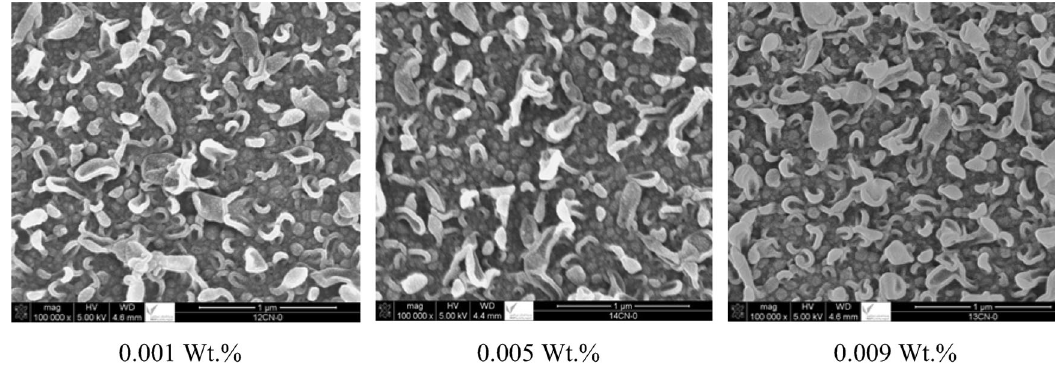
Fig. 7 SEM images of MWCNT in MPD